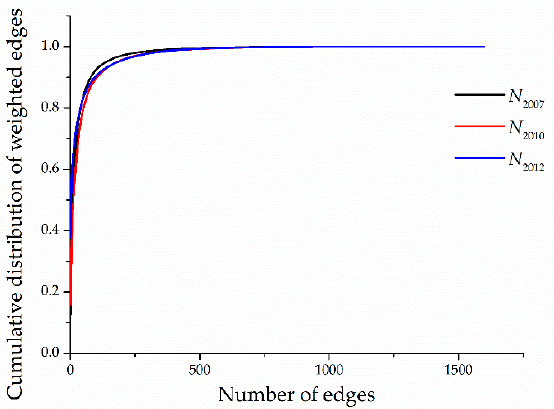
Figure 6. Cumulative probability distribution of the weighted edges. The abscissa is the number of edges in the network, and the ordinate is the cumulative probability of the weighted edges sorted in descending order.